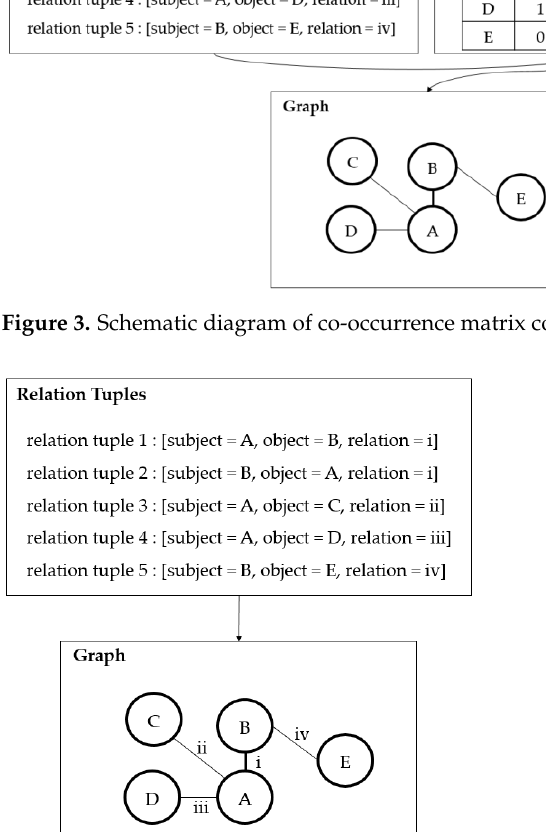
Figure 3. Schematic diagram of co-occurrence matrix construction.